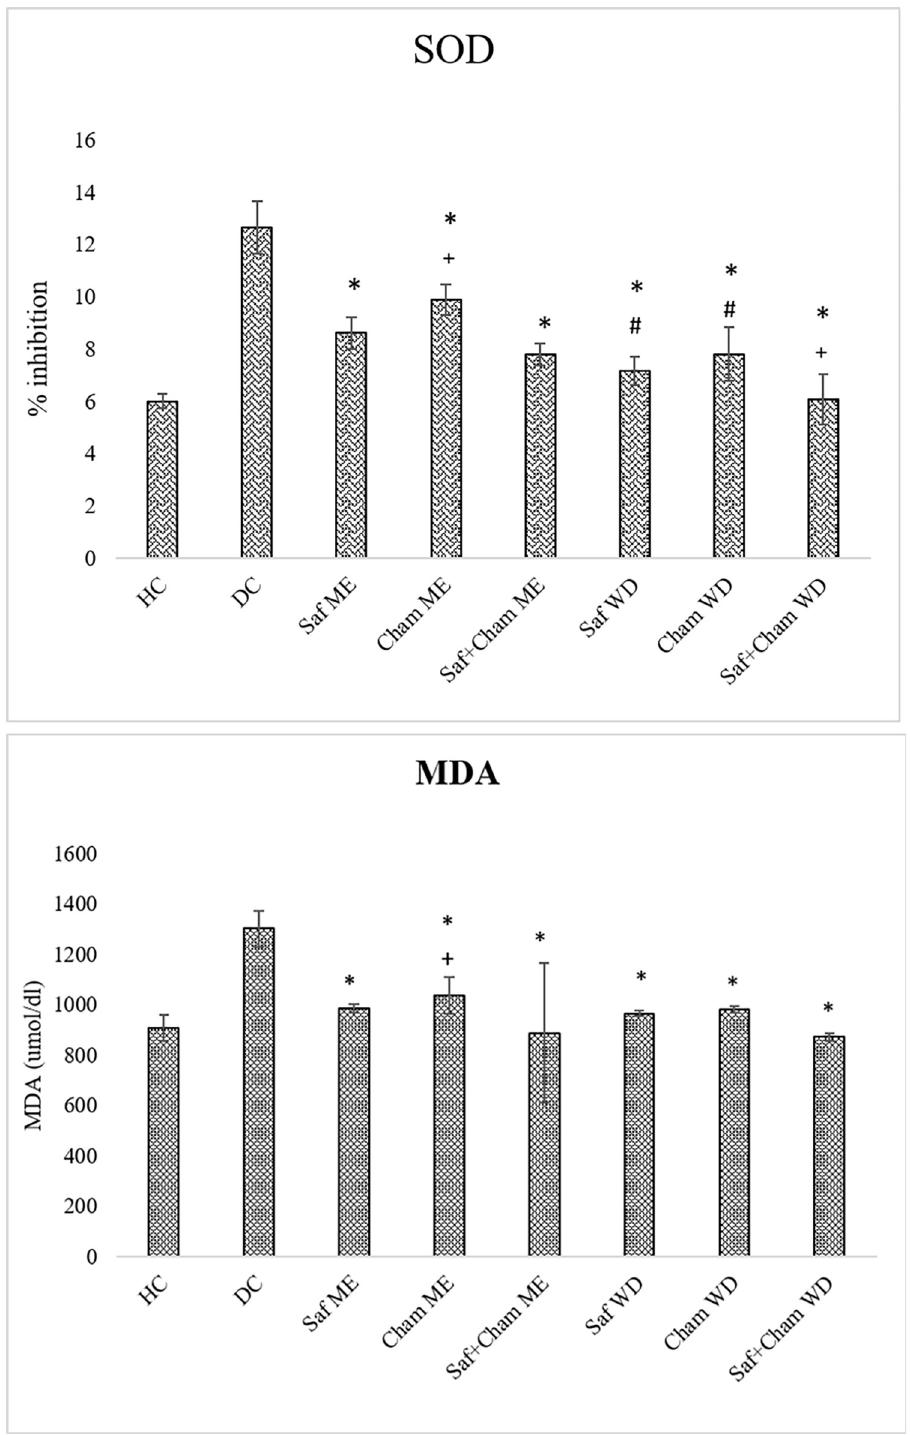
Fig 6. a: Effects of saffron, chamomile and their co-administration in ME and WD on SOD in streptozotocin-induced diabetic rats. Values are presented as means ± SD (n = 10). Tukey’s test significant values: � p < 0.05 from control DC, + p < 0.05 from Saf+Cham ME group, # p < 0.05 from Saff+Cham WD. b: Effects of saffron, chamomile and their co- administration in ME and WD on MDA in streptozotocin-induced diabetic rats. Values are presented as means ± SD (n = 10). Tukey’s test Significant values: � p < 0.05 from control DC, + p < 0.05 from Saf+Cham ME